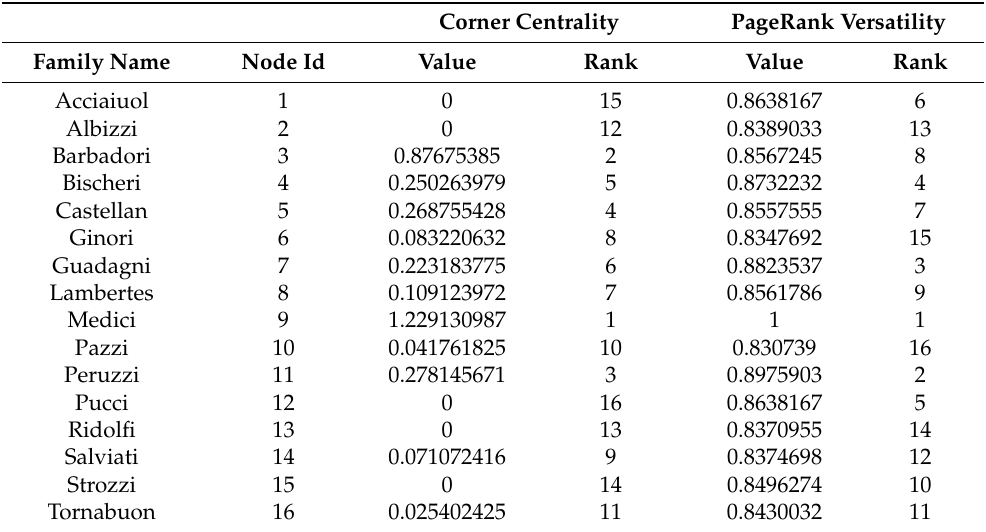
Table 5. Corner centrality values and Pagerank versatility for the Florentine Families multiplex network. Corner